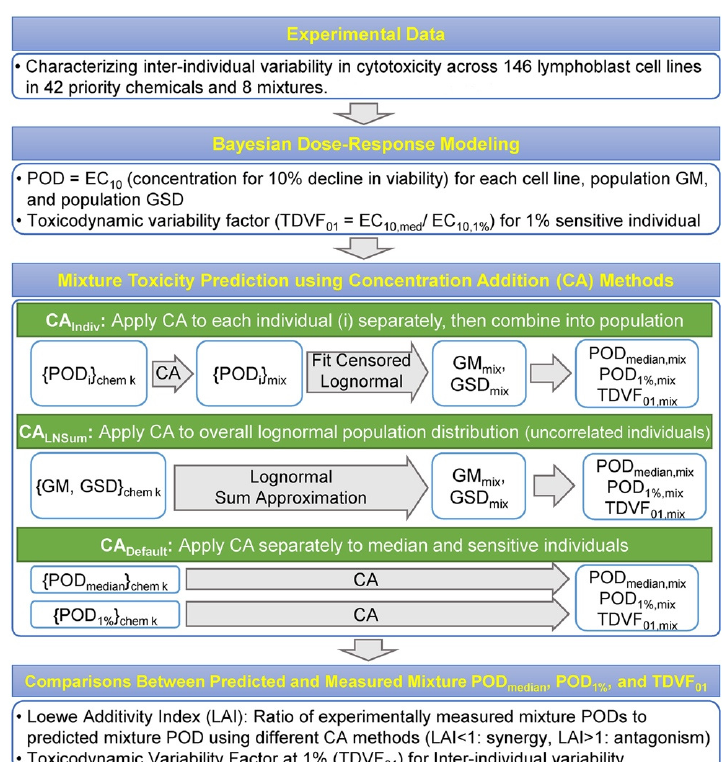
Figure 1. Overall workflow to evaluate population variability in mixture additivity. First, lymphoblastoid cell lines from 146 individuals were exposed in vitro to 42 chemicals and 8 defined mixtures in concentration–response [47]. Cytotoxicity was measured as the endpoint of interest, from which point of departure (POD) and TDVF values were derived using Bayesian concentration–response modeling. Next, the results from individual chemicals were used to predict those of the defined mixtures assuming three different methods for applying concentration addition (CA) to a popula- tion, and then compared with the measured POD from the defined mixture experiments. Accuracy was characterized by calculating the Loewe Additivity Index (LAI), which refers to the ratio of the measured and CA-predicted values. Additional details are described in Section